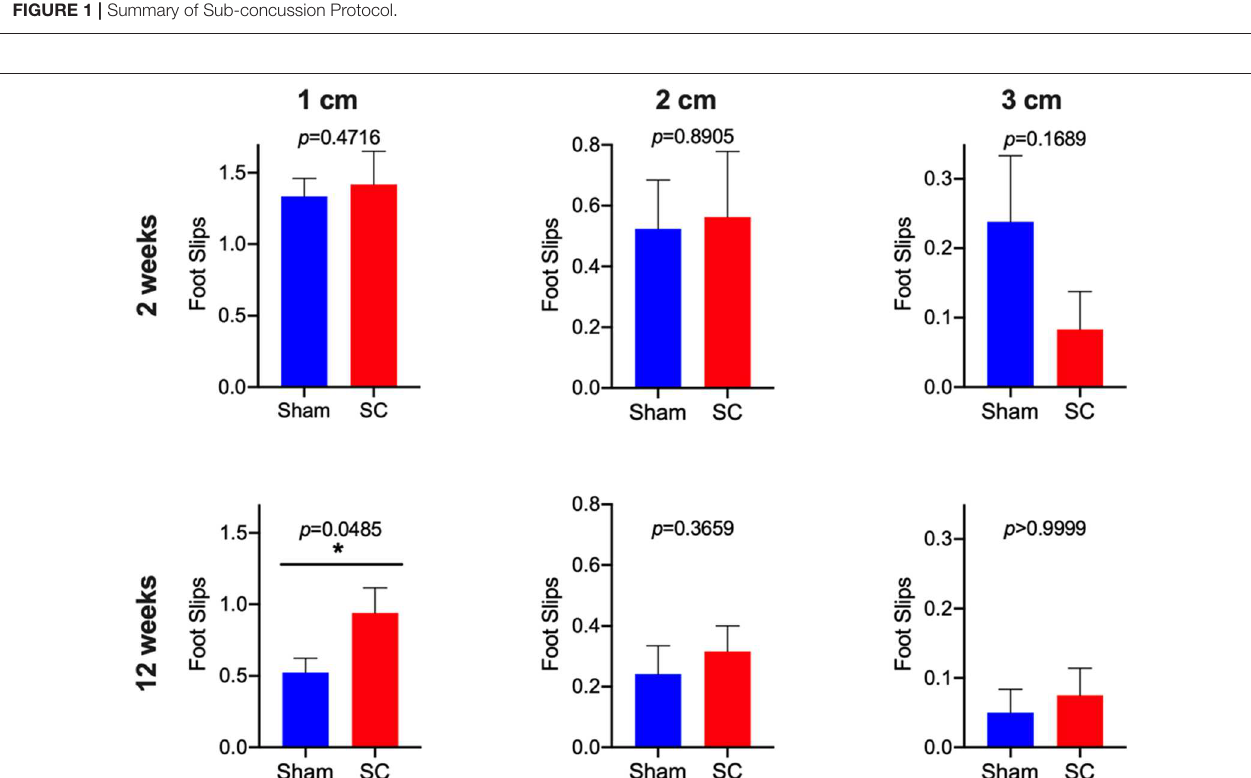
FIGURE 2 | Beamwalk Test. Neuromotor function was tested by using beamwalk test with 1, 2, and 3cm beams in Sham and Sub-concussion (SC) group rats after 2 or 12 weeks of repeated sub-concussions. The number of foot slips are presented as a mean ± SEM of 3 trials. Statistically significant differences between Sham and SC groups at each time point was tested with unpaired t -test or non-parametric Mann-Whitney test (* p <